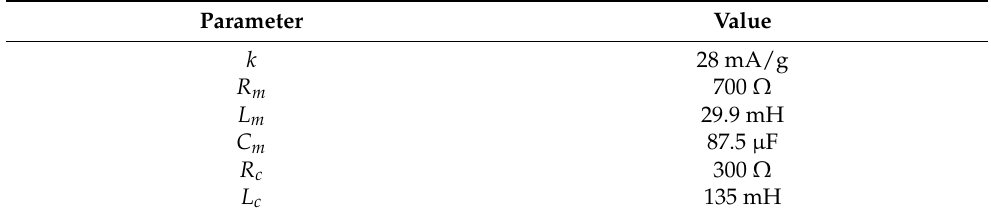
Table 1. Parameters of the equivalent circuit of the tested commercial electromagnetic harvester.